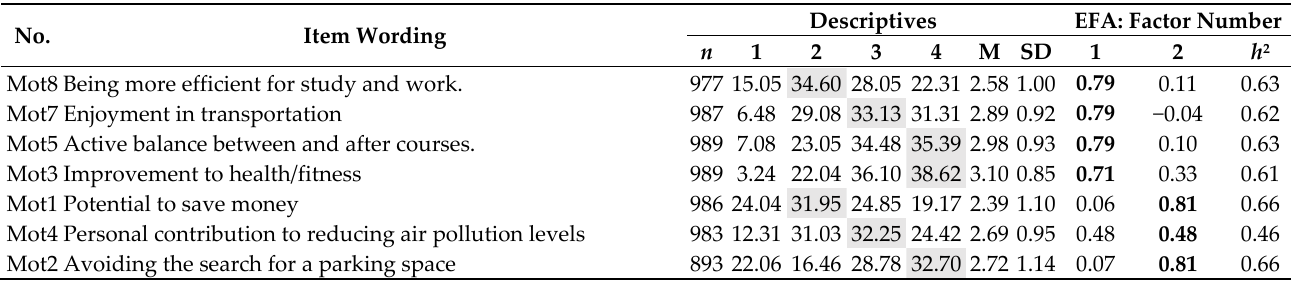
Table A5. Item’s descriptives (frequencies in %; 1 = totally disagree; 2 = more likely to disagree; 3 = more likely to agree; 4 = totally agree), factor loadings, and communalities ( h 2 ) of the explorative factor analysis (EFA) of motivator items. No. Mot8 Being more efficient for study and work.